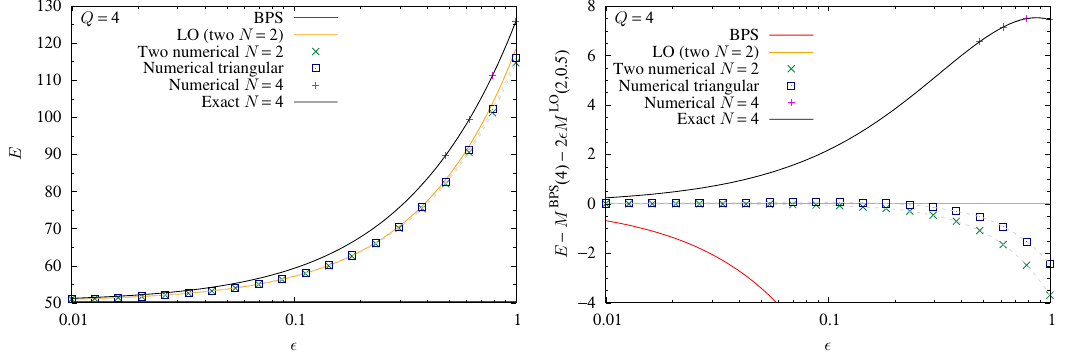
Figure 10. Left panel: energies of the baby Skyrmion solutions in the Q = 4 sector. The red line shows the BPS bound, the orange line is the LO correction for two N = 2 baby Skyrmions. The numerical solutions are: the two N = 2 Skyrmions side-by-side (green crosses), the triangularly symmetric baby Skyrmion (blue dotted squares), and the axially symmetric N = 4 Skyrmion (magenta pluses). The numerical N = 4 solution is compared to the exact solution (using ODE computations) shown with a black solid line. The right-hand side panel shows the same energies, but with the BPS and the LO correction subtracted off. Around (cid:15) . 0 . 4 the axially symmetric N = 4 soliton becomes unstable and decays to the triangularly symmetric one — which is just metastable.